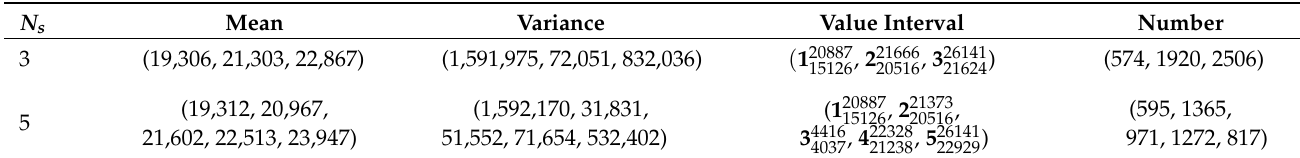
Figure 6. The hidden states of thrust: ( a ) under N s = 3; ( b ) under N s = 5. Table 3. Analysis of thrust by HMM.